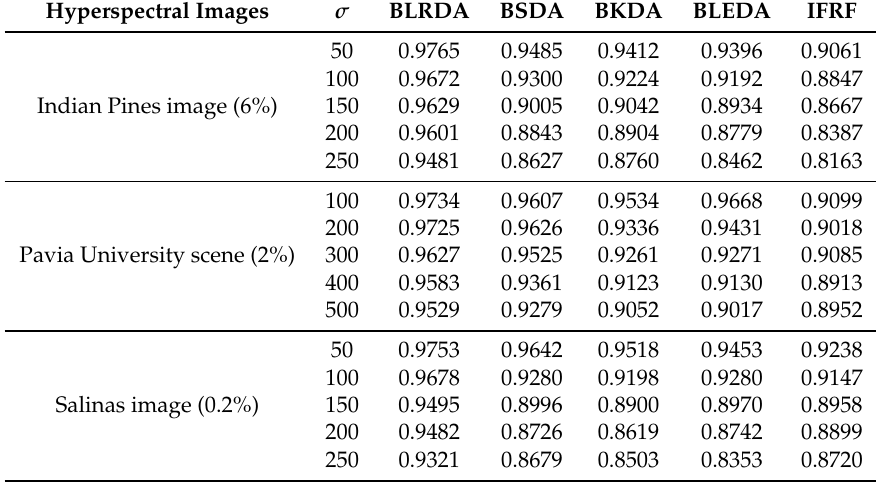
Table 6. Overall accuracy with varying variance Gaussian noise on three HSIs.